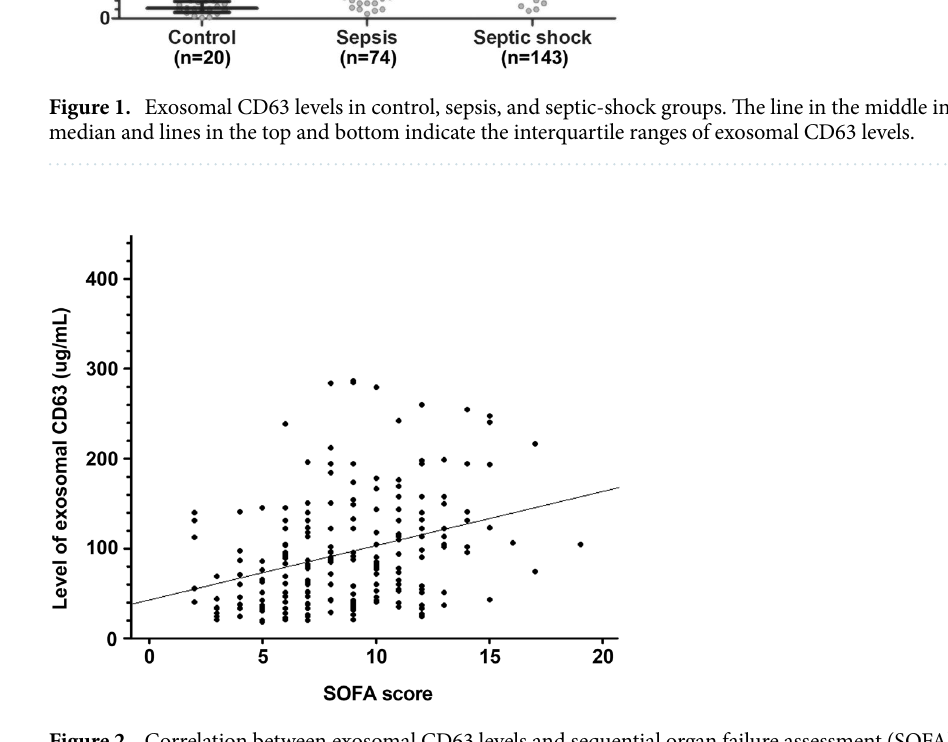
Figure 2. Correlation between exosomal CD63 levels and sequential organ failure assessment (SOFA) scores in patients with sepsis. Slope: 6.73 (95% confidence interval (CI); 4.28–9.19), r 2 : 0.12, Pearson’s r: 0.35 (95% CI; 0.22–0.46, p <